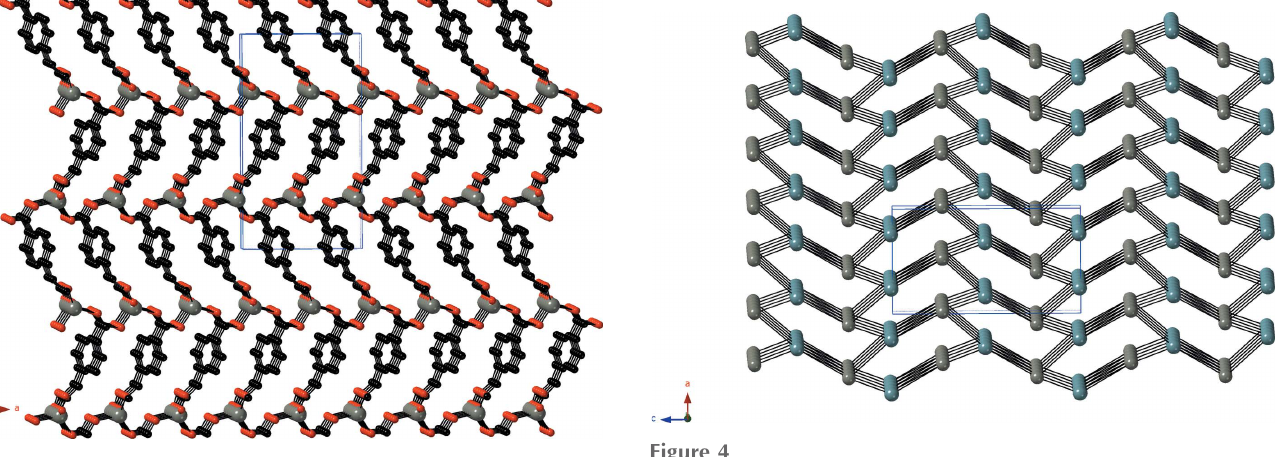
Figure 3 A rendering of the three-dimensional [Zn(4-cmb)] n coordination polymer network in the title compound, viewed down and slightly offset from the b -axis direction.